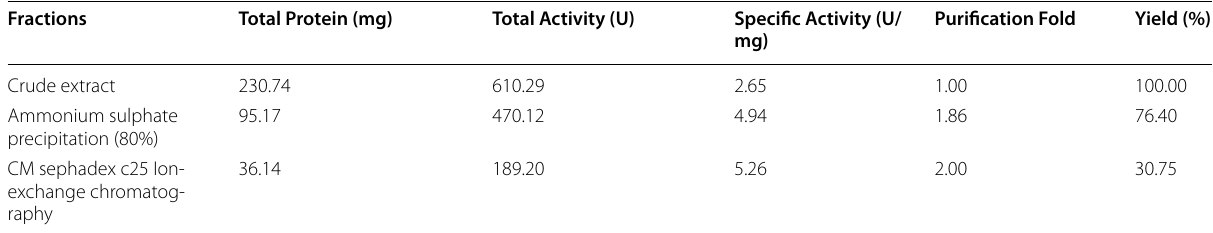
Table 1 Summary of purification for alpha-amylase obtained from the submerged fermentation of P. tuber-regium Fractions Total Protein (mg) Total Activity (U) Specific Activity (U/